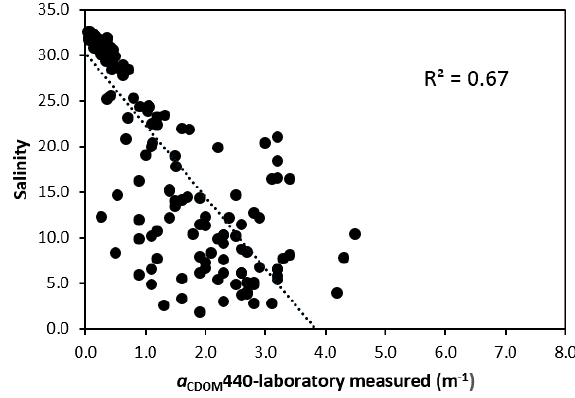
Figure 3. Relationship between laboratory measured colored dissolved organic matter absorptions at 412 and 440 nm and salinity ( n = 176) from water samples collected from NB, NR, and SAB (see Table 1 for estuary abbreviations).